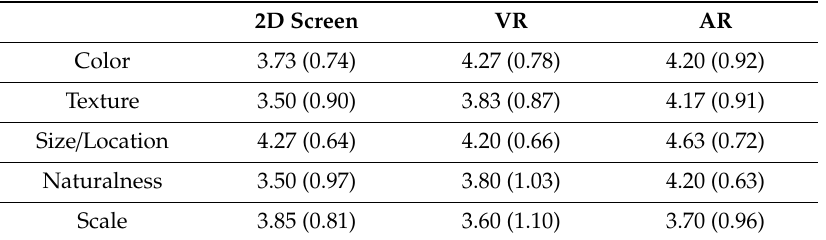
Table 4. Visual presentation